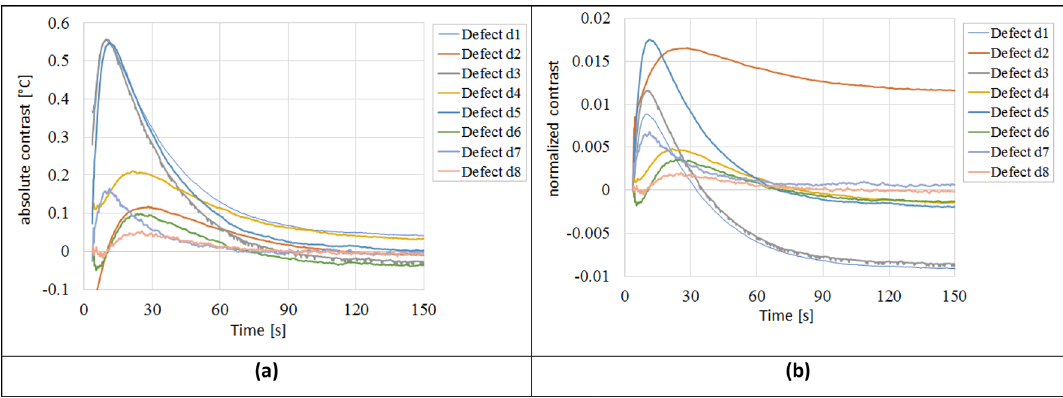
Fig. 12 Absolute contrast ( a ) and normalized contrast ( b ) for the traditional thermography (heating time 3 s)